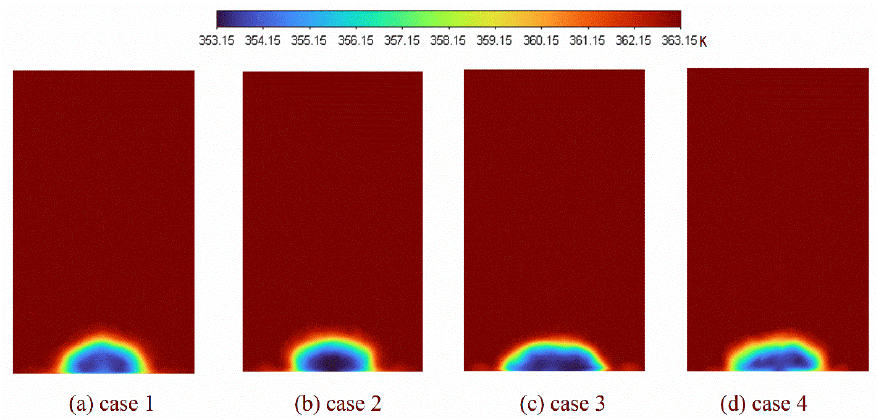
Figure 8. Comparison of cross-sectional average temperature distribution contour maps.